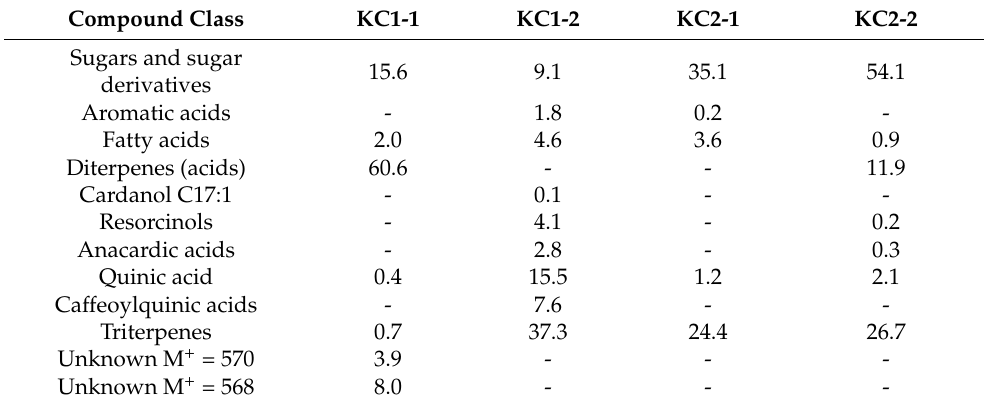
Table 1. Chemical composition of propolis and cerumen extracts by compound class (GC-MS; % of TIC (Total Ion Current).